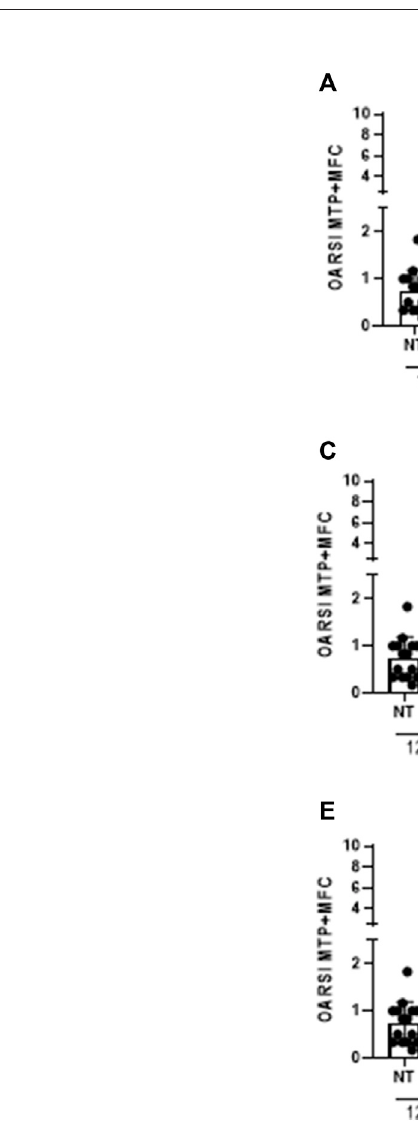
FIGURE3| NoeffectonjointpathologyinUMHET3micefollowingtreatmentwith17- α -Estradiol,AcarboseandRapamycin (A) Cartilagechangesinfemalemiceat 12 months (NT n = 15; 17 α E n = 8) and 22 months (NT n = 18; 17 α E n = 9) following treatment with 17- α -Estradiol (17 α E); (B) Cartilage changes in male mice